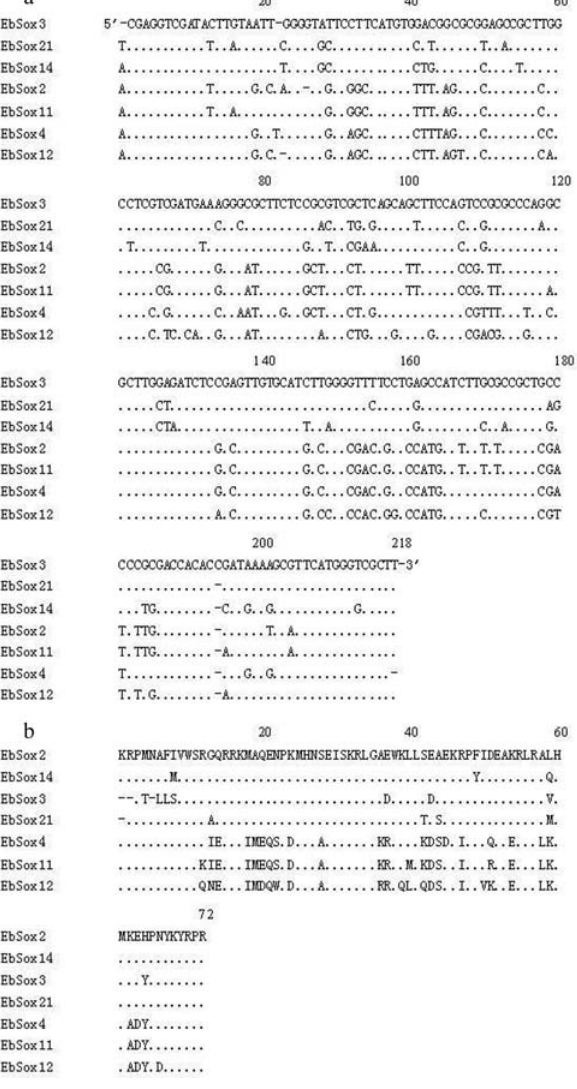
Figure 1 - Sox gene HMG-boxes of Eremias breuchleyi . (a) DNA se- quence; dots indicate identities with EbSox3 ; (b) putative amino acid se- quence; dots indicate identities with EbSox2